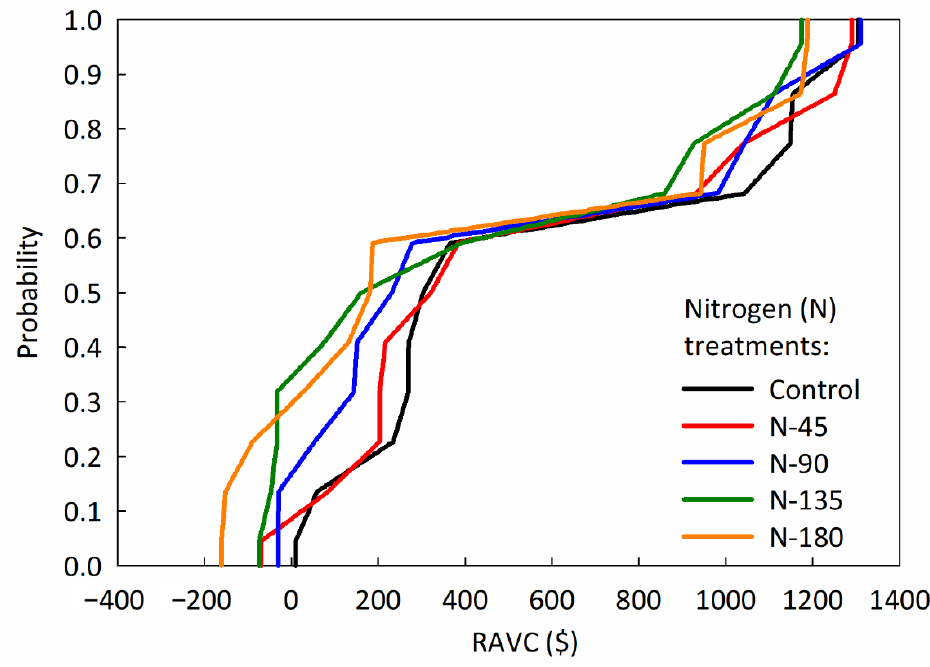
Figure 2. A Cumulative Distribution Function (CDF) comparing returns above variable cost (RAVC) across various N rates for DP 1646.